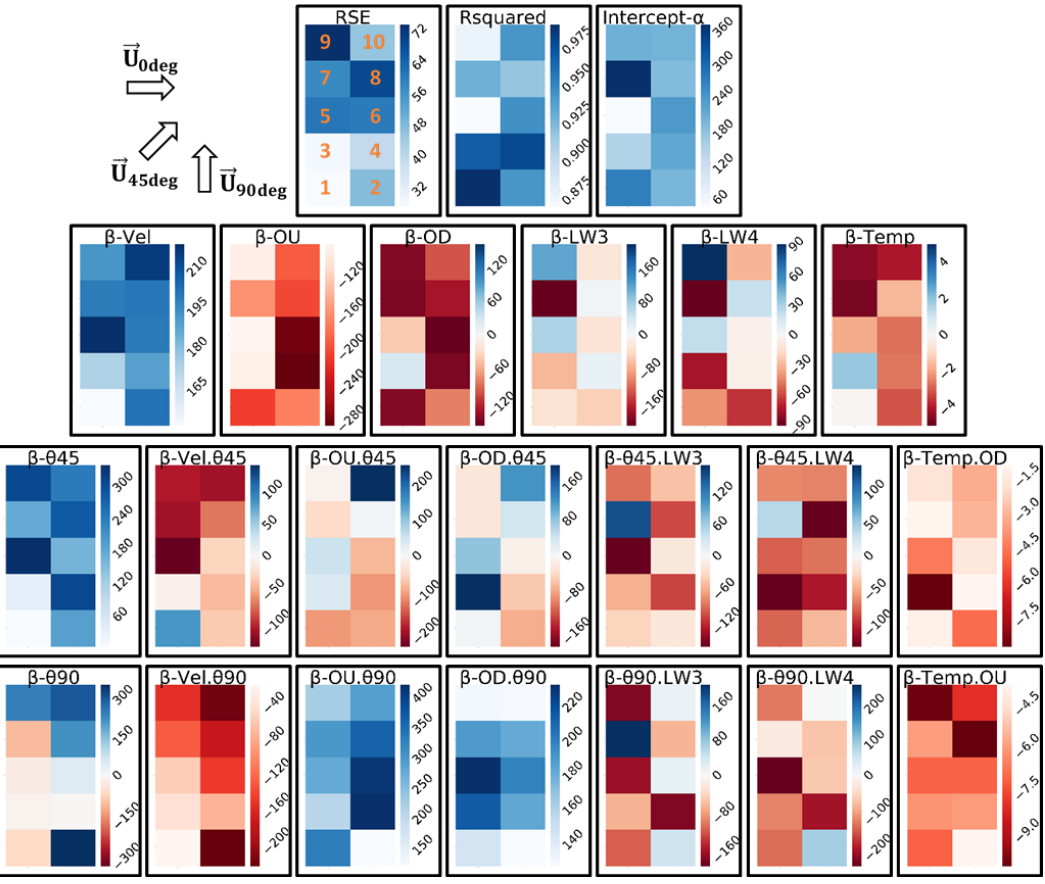
Figure 9. RSE, R 2 and coefficients of the AER Box . i of Equation (11) corresponding to the forced convection group. Equation (12) represents the fitted model for AER Box . i of the mixed convection group. Again, the green-colored terms are the ones that can be found in Equation (9) of the